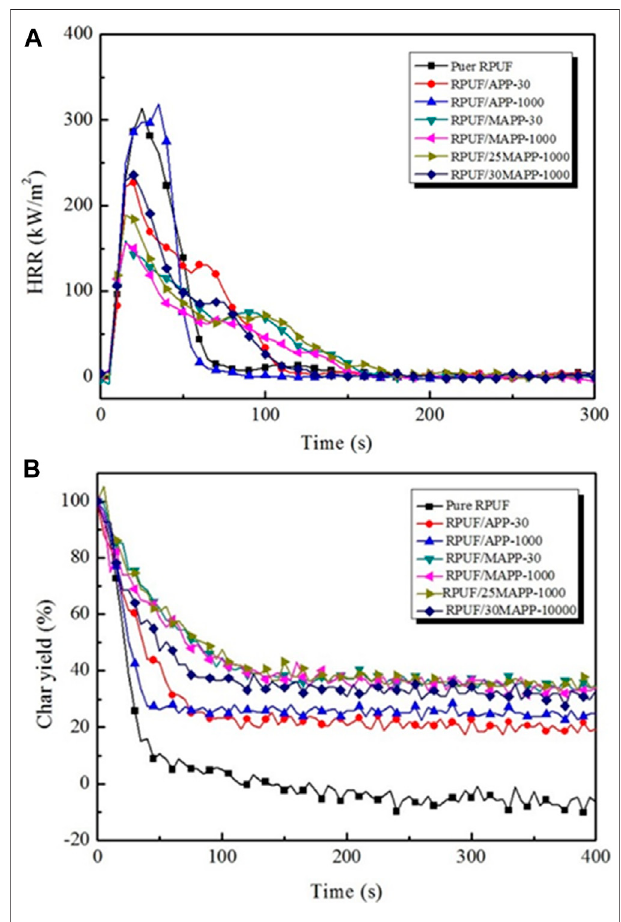
FIGURE 5 | HRR (A) and Char yield (B) curves of FR-RPUFs. Macroscopic and Microscopic Morphologies of Residual